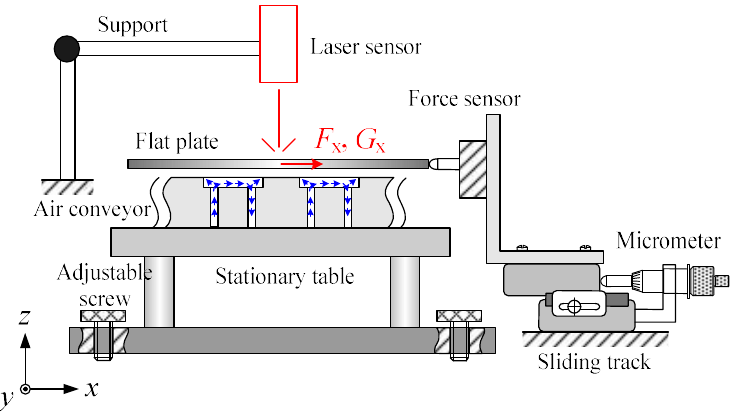
Figure 6. Schematic of the apparatus for viscous force measurement.